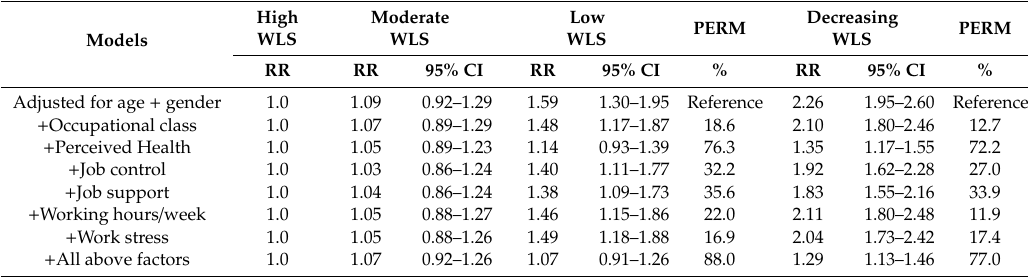
Table 4. Association between satisfaction in working life (WLS) and intention to retire with simultaneous adjustments for di ff erent characteristics of the study population.